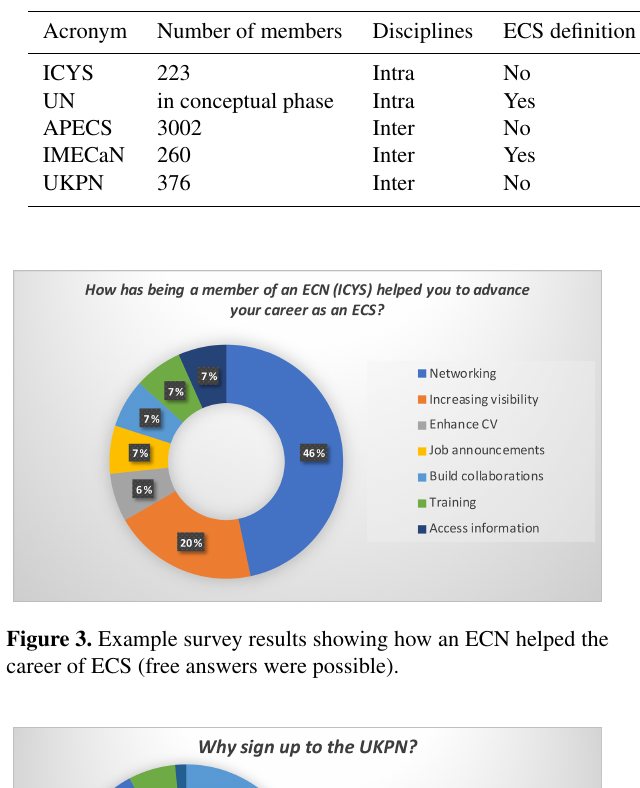
Table 1. Overview of structures in exemplary ECN. For an explanation of acronyms see Appendix A.